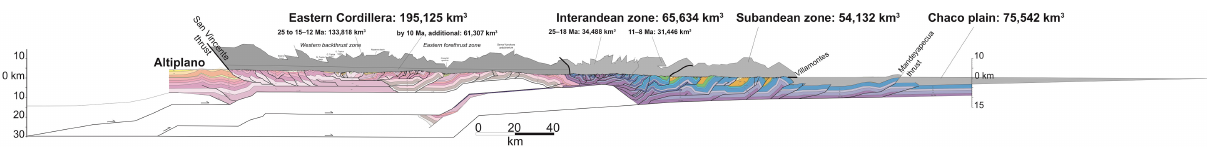
FIGURE 6 | Gray polygons showing the areas that represent eroded material from different portions of the cross section. The areas were multiplied by the north–south extent of the map in Figure 1 to determine the eroded sediment volumes shown in this figure. Note that the Eastern Cordillera shows estimates for two distinct time intervals, and the Interandean Zone differentiates material eroded from the western and eastern segments. The basal dip of the foreland was continued eastward to determine the approximate position of the pinchout of the